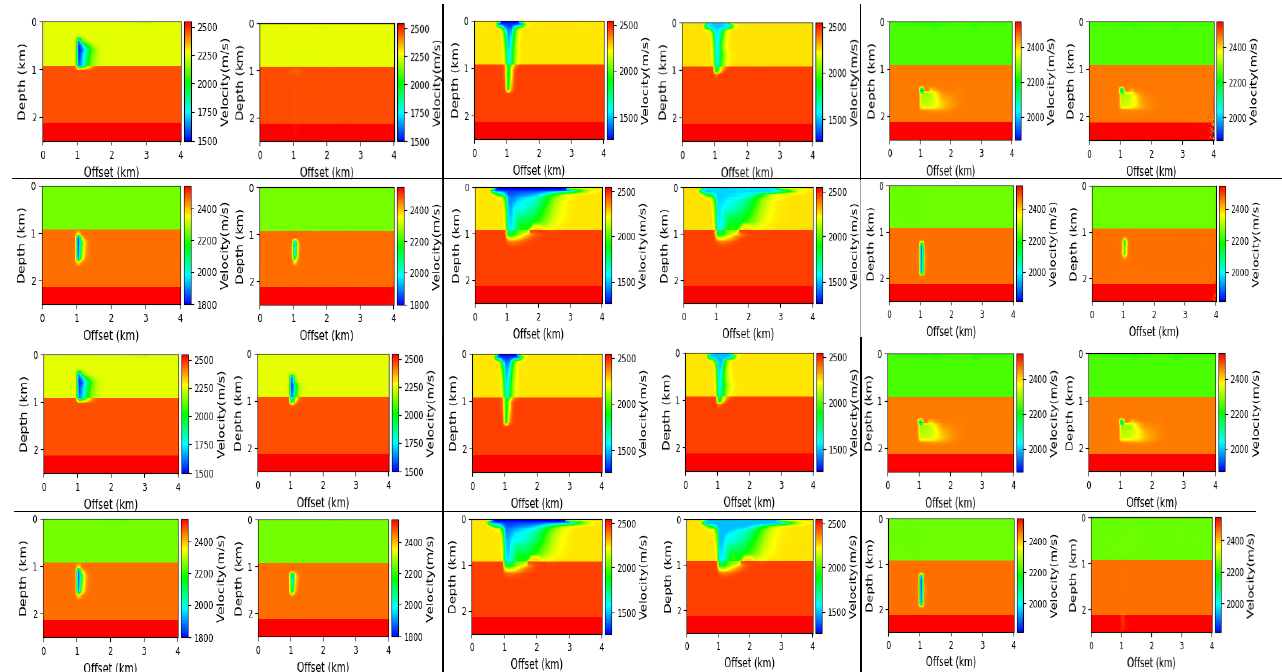
Figure 11. Reconstruction results for no-noise (top) and noise-aware (bottom) models on the Kimber- lina data. Ground truth (left) and Prediction (right).